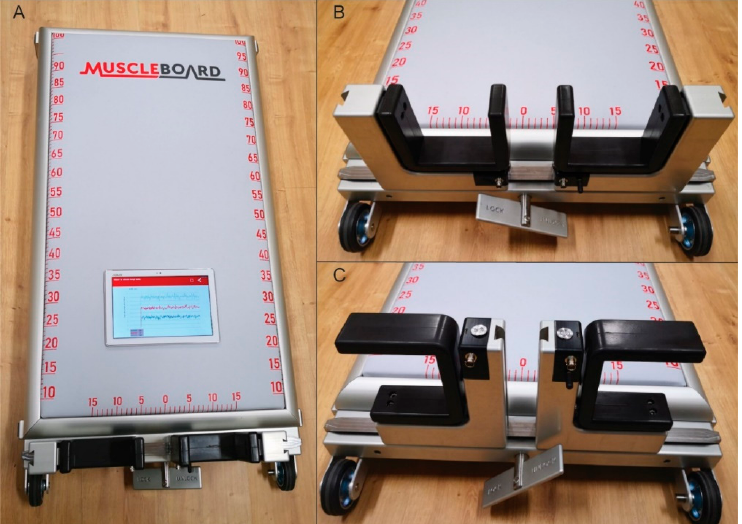
Figure 1. Portable dynamometer MuscleBoard ® . ( A ) = the device from above: measurement scales, tablet with software; ( B ) = sensor braces with load cells in position for measuring horizontal move- ment (left or right); ( C ) = sensor braces with load cells in position for measuring vertical movement (up or down).